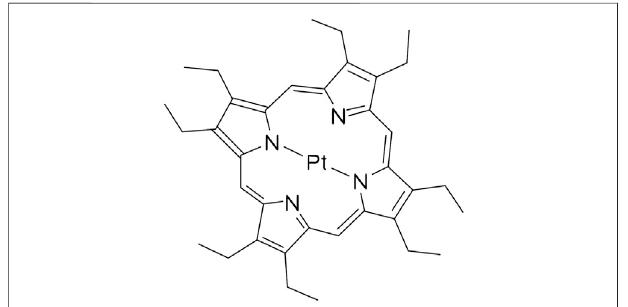
FIGURE 2 | The molecular structure formula of